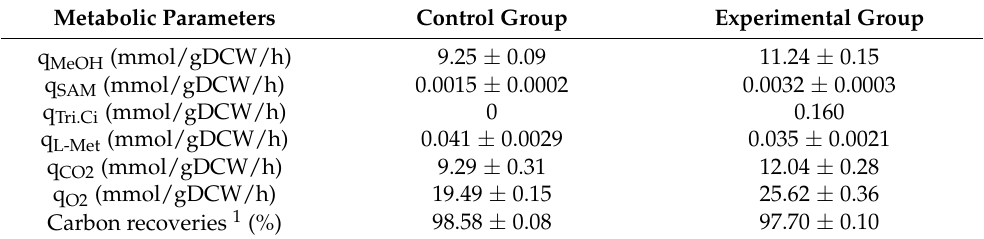
Table 1. The metabolic parameters of control and experimental groups in the induction phase 24–36h. Metabolic